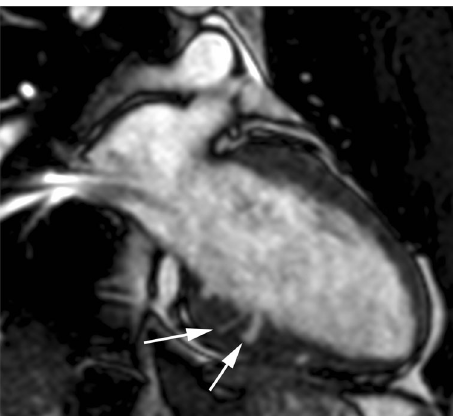
Fig. 1 22-year-old man with myocardial crypts and a family history of HCM without myocardial hypertrophy. Two-chamber steady-state free precession (SSFP) cine MR image at end-diastole shows V-shaped myo- cardial crypts perpendicular to the endocardial border at inferior LV wall (arrows). The crypts close completely during systole (not